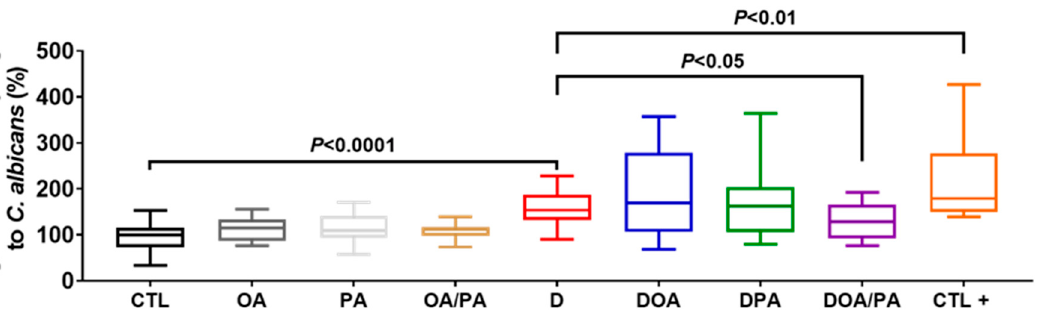
Figure 3. Migration of macrophages to C. albicans through Caco2 cells challenged with DSS and treated with fatty acids (FAs). CTL: control (migration of macrophages through Caco-2 cells untreated with DSS); OA: migration of macrophages through Caco-2 cells treated with OA only and unchallenged with DSS; PA: migration of macrophages through Caco-2 cells treated with PA only and unchallenged with DSS; OA/PA: migration of macrophages through Caco-2 cells treated with both FAs and unchallenged with DSS; D: migration of macrophages through Caco-2 cells challenged with DSS; DOA: migration of macrophages through Caco-2 cells challenged with DSS and treated with OA; DPA: migration of macrophages through Caco-2 cells challenged with DSS and treated with PA; DOA/PA: migration of macrophages through Caco-2 cells challenged with DSS and treated with both FAs; CTL+: positive control (migration of macrophages without Caco-2 cells). The results were obtained from three independent experiments.